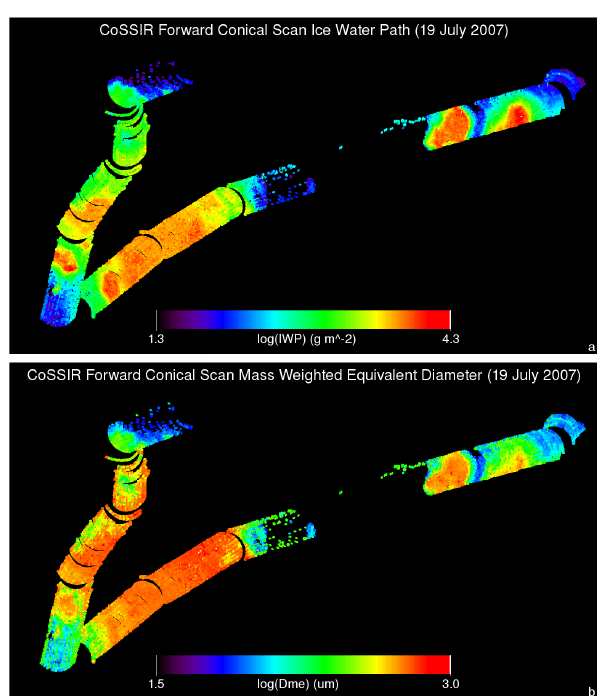
Fig. 23. Ice water path (a) and D me (b) of cloudy pixels retrieved from CoSSIR forward conical scans. The log color scale for IWP is from 20 to 20000gm − 3 , while the log color scale for D me is from 30 to 1000µm. Only pixels with an ER-2 roll angle < 5 ◦ are used. The pixels are projected to 5km altitude. The longi- tude range is 90.2 ◦ W to 94.6 ◦ W, and the latitude range is from 6.8 ◦ N to 10.0 ◦ N. The retrievals are from 13.2 to 14.5hUTC on 19 July